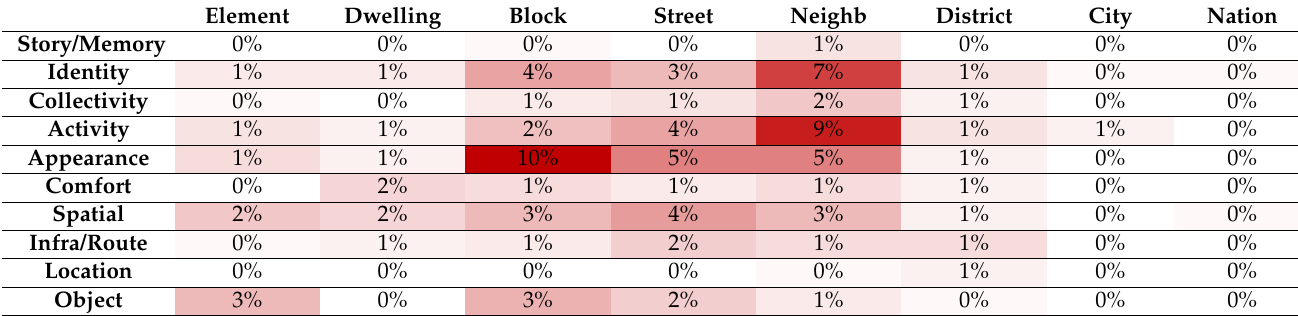
Table A2. Residents: 29 respondents.